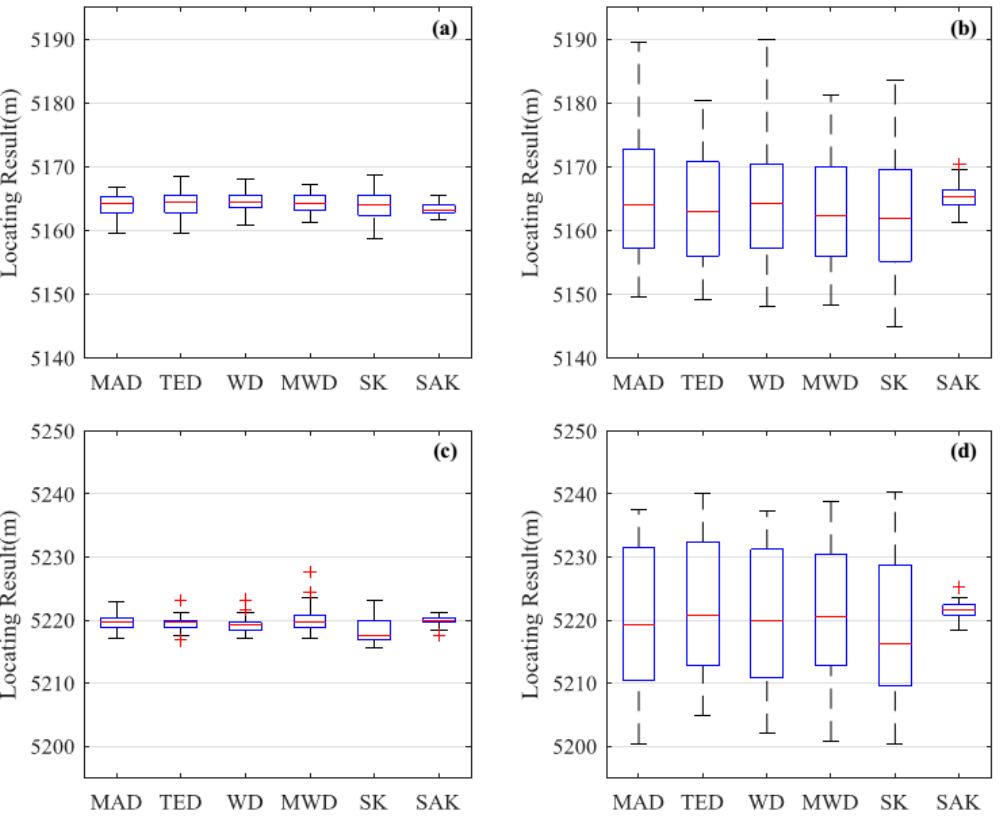
Figure 8. The statistic results of locating results. ( a ) The result of pencil-break vibration under 100 ns pulse width; ( b ) The result of pencil-break vibration under 500 ns pulse width; ( c ) The result of digging under 100 ns pulse width; ( d ) The result of digging under 500 ns pulse width. Table 2. The average and standard deviation of the locating results under different pulse widths.